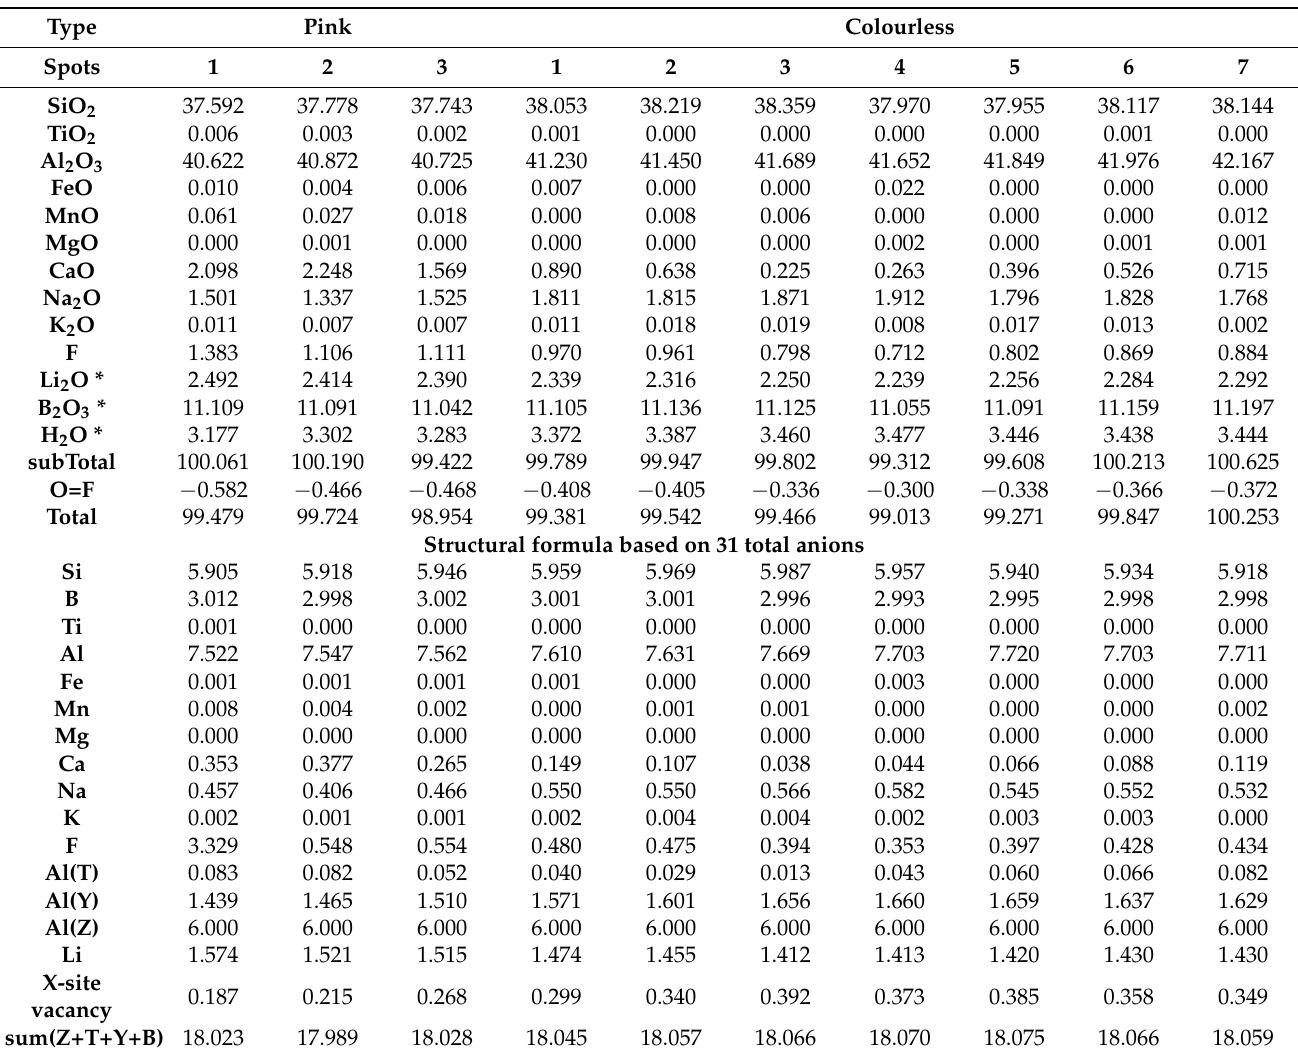
Table 1. Microprobe data of tourmalines from the pink part to the colourless part.